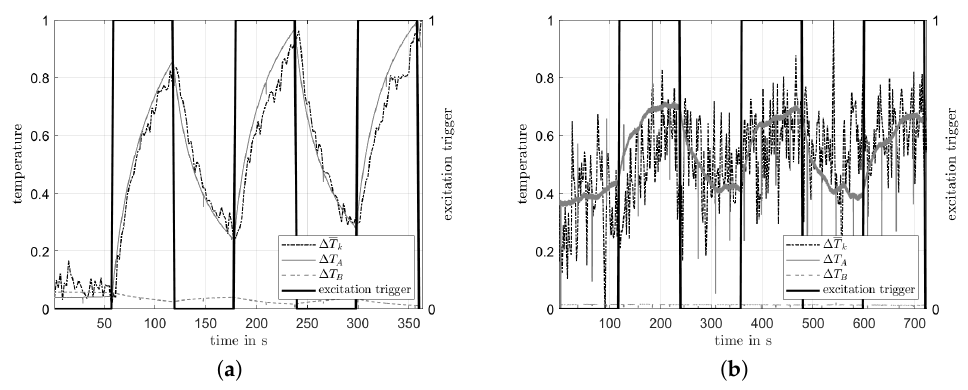
Figure 8. ( a ) Shows the normalized temperature profile of the averaged difference of the pristine and damaged area ∆ T k resulting of the IR-images compared to the results of the surface temperature sensors ∆ T A and ∆ T B at the experiment, in which the piezoelectric stack actuator is used as excitation source, whereas ( b ) shows the results of the experiment with the PWAS bonded on the structure used as excitation source. The excitation trigger signal is schematically shown whether the excitation is on (1), or off